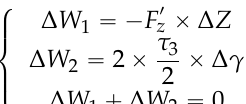
Figure 10. Approximation model. Figure 9. Model of virtual work.